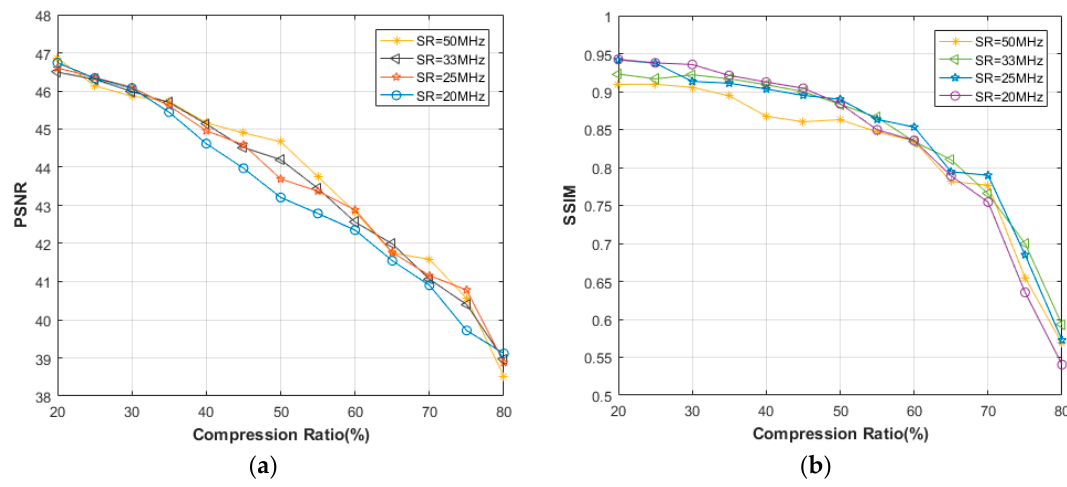
Figure 18. Comparative ( a ) PSNR, ( b ) SSIM between different SRs in frequency domain, using experimental through-holes data.